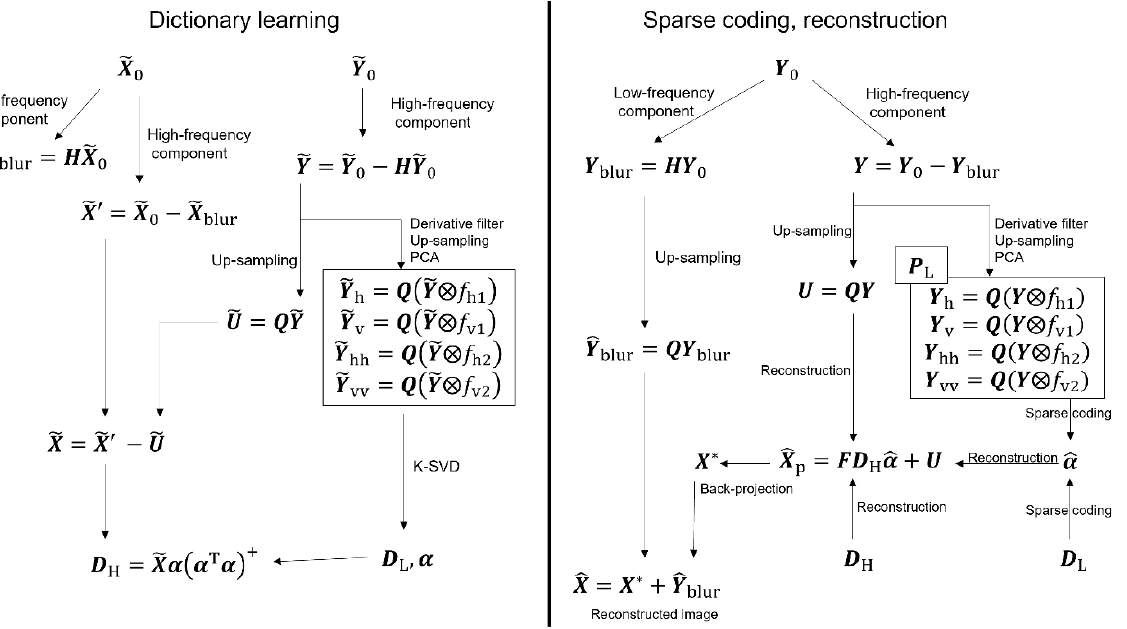
Figure 2. Detailed flowchart of ScSR. It consists of two processes: dictionary learning and recon- struction by sparse coding.